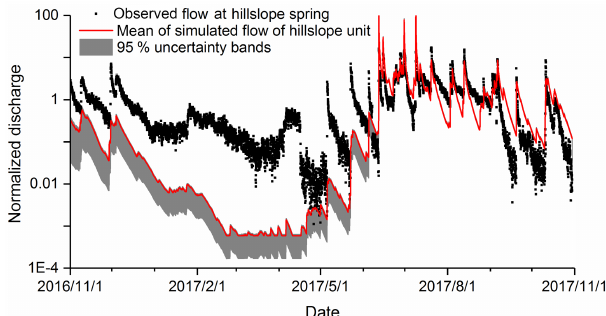
Figure 6. Observed discharge at hillslope spring (in Fig. 1) against the simulated discharge of the hillslope unit (mean of the simula- tions for the best 500 parameter sets). Note: values are